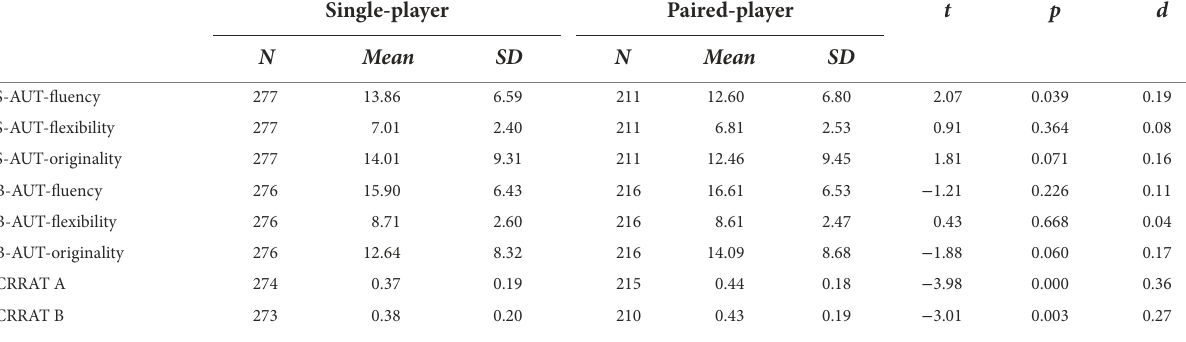
TABLE 7 Differences in AUT and CRRAT Scores under single-and paired-player